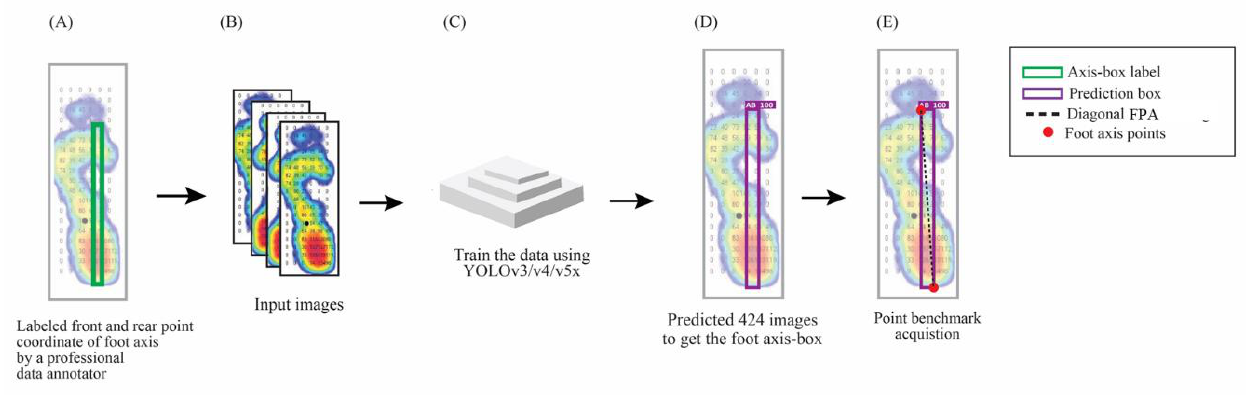
Figure 3. The illustration of angle-box for foot progression angle (FPA) in plantar pressure image with the YOLO model. ( A ) The dataset is labeled by the professional annotator ( B ). Input the data of labeled images. ( C ) Training using YOLOv3, v4, and v5x. ( D ) testing the 424 images to get the foot angle-box. ( E ) Determine the foot axis point acquisition based on the foot profile-box.